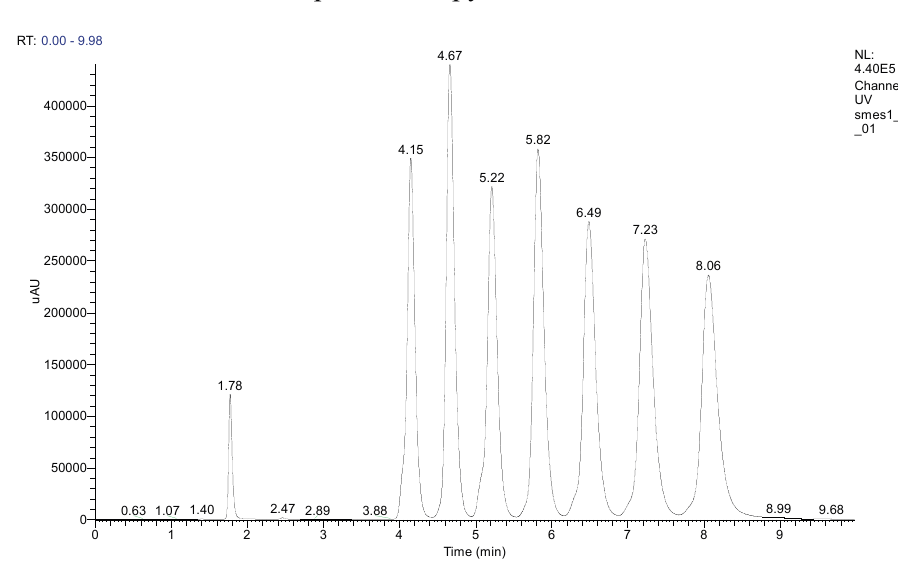
Scheme 1. Preparation of pyridinium-4-aldoxime salts.